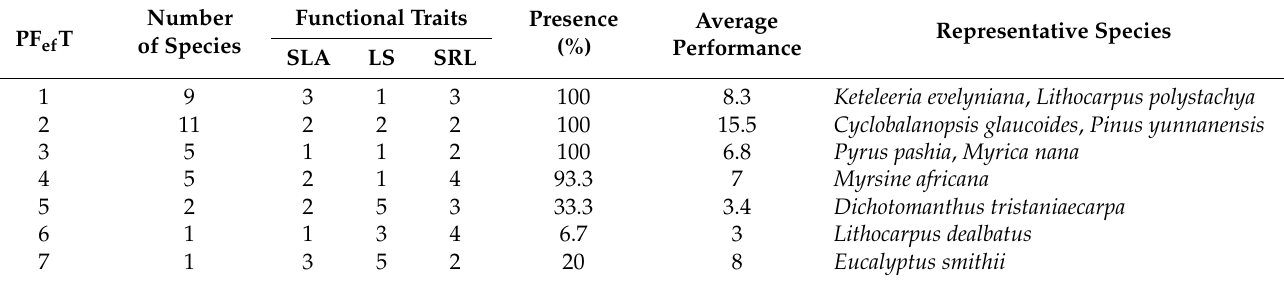
Table 4. Plant traits and the identification of plant functional effect types (PF ef Ts).